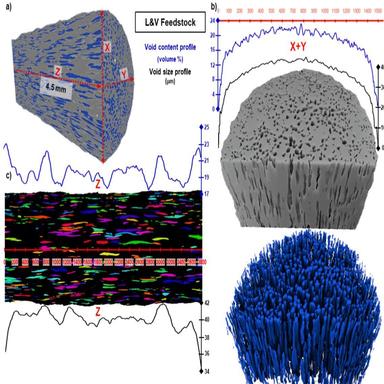
L&V Feedstock a) 3D visualisation of the sample's tomogram image, digitally cut in half, showing X, Y, and Z-axis direction and, in blue, segmented voids; b) void content and size profiles for combined X and Y directions plotted against (top) horizontal slices scale bar, (centre) 3D visualisation of a subset segmented image showing fibres and resin (grey) with voids set 100 % transparent, and (bottom) 3D visualisation of same subset showing segmented voids (blue) with fibres and resin set 100 % transparent;